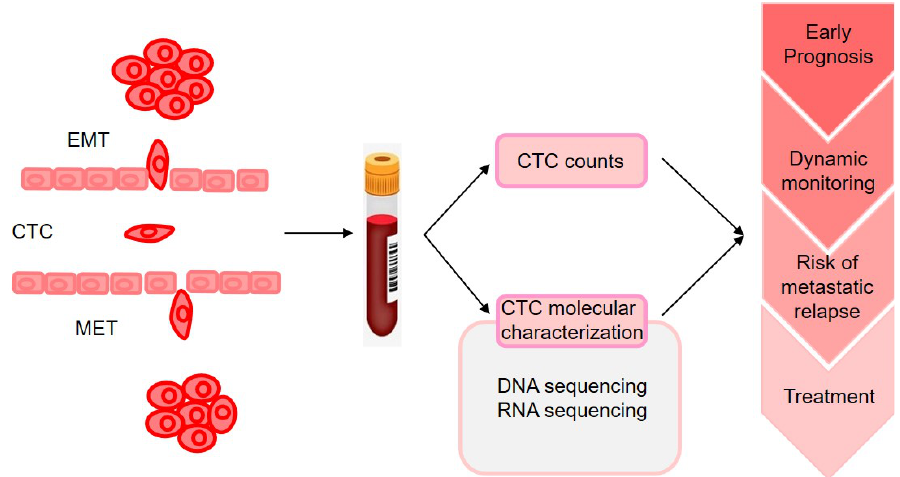
Figure 2. Clinical applications of CTCs sequencing for personalized medicine. Blood samples can be analyzed repeatedly for early prognosis, metastatic progression, monitoring the efficacy of therapies, and resistance mechanisms. CTC molecular characterization predict risk of metastatic recurrence at a specific organ and drive therapy potentially. EMT: epithelial-mesenchymal transition; MET: mesenchymal to epithelial transition.